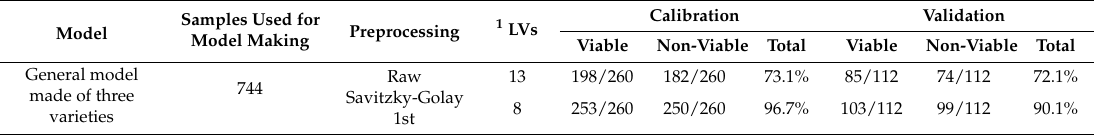
Table 1. Seed viability detection in prediction for the general model.